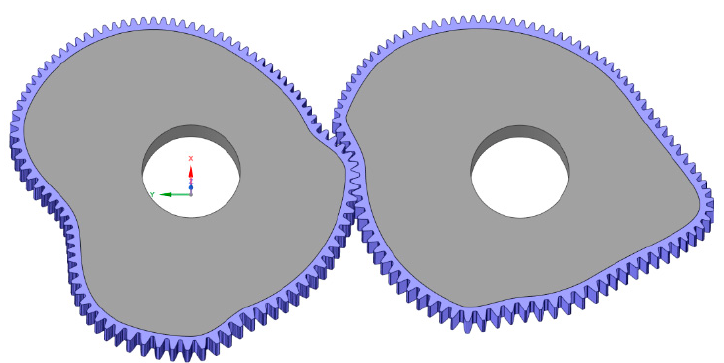
Figure 12. Three-dimensional modeling of non-circular gear.